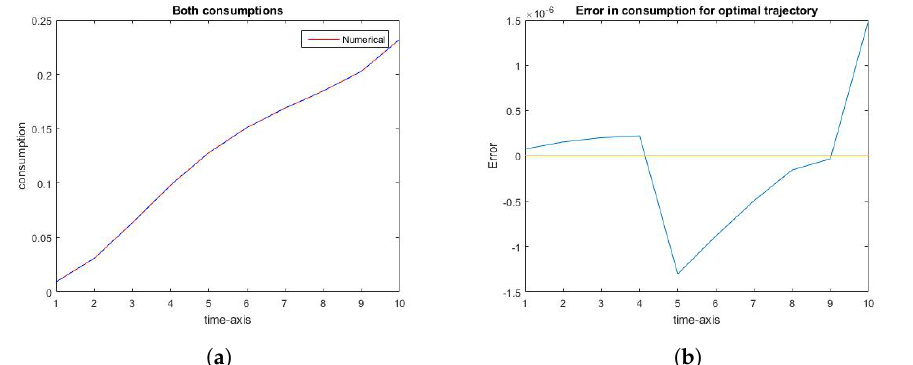
Figure 6. Accuracy of the trajectory of the Nash equilibrium strategy. ( a ): The optimal consumption path, c N ( t , X ( t )) , numerical (red) and actual (blue dashed) for the Nash equilibrium; ( b ): The error in the optimal consumption path, c N ( t , X ( t )) , for the Nash